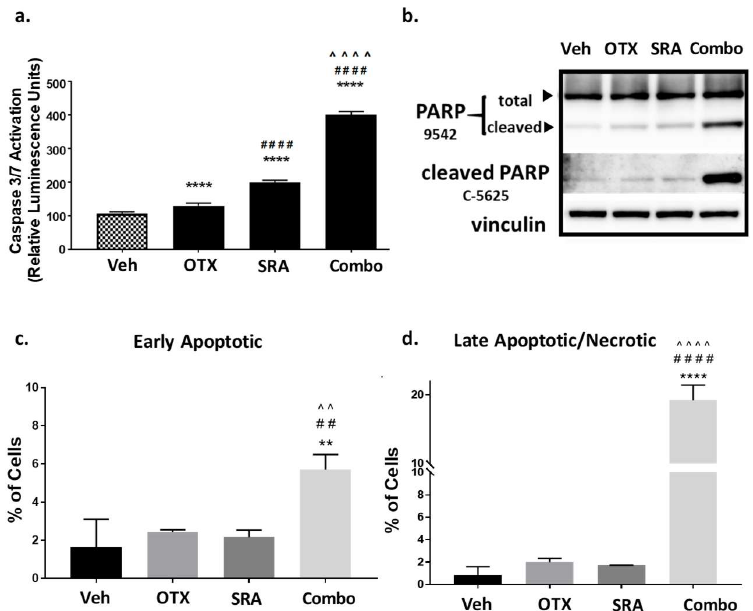
Figure 5. Combination BETi/OTX-015 + CHK1i/SRA737 increases apoptotic cell death in OS cells. ( a – b ) Saos2 cells were treated with a vehicle, BETi/OTX-015, CHK1i/SRA737, or combination of